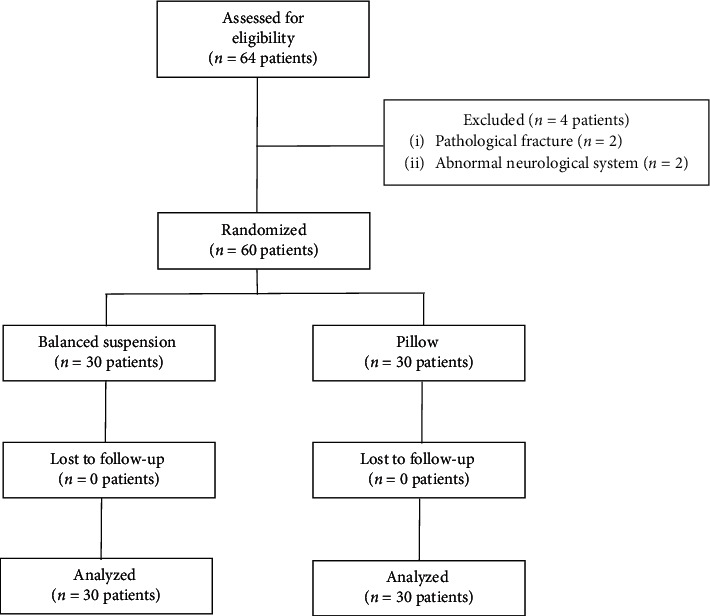
Flow study diagram.